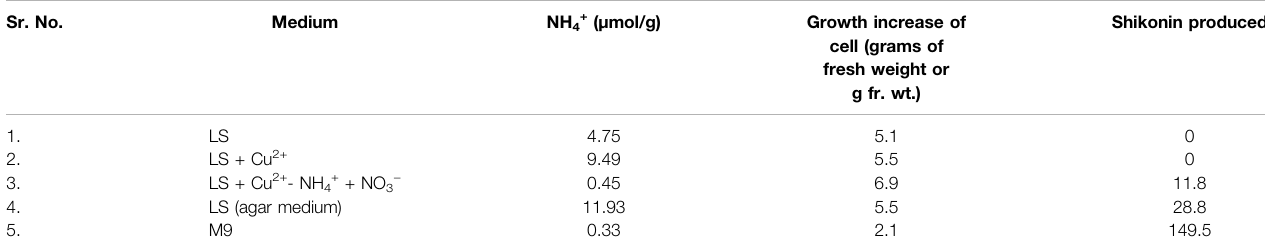
TABLE 4 | Shikonin production in the presence of ammonium ions in a different medium (Yazaki et al., 1987). Sr.